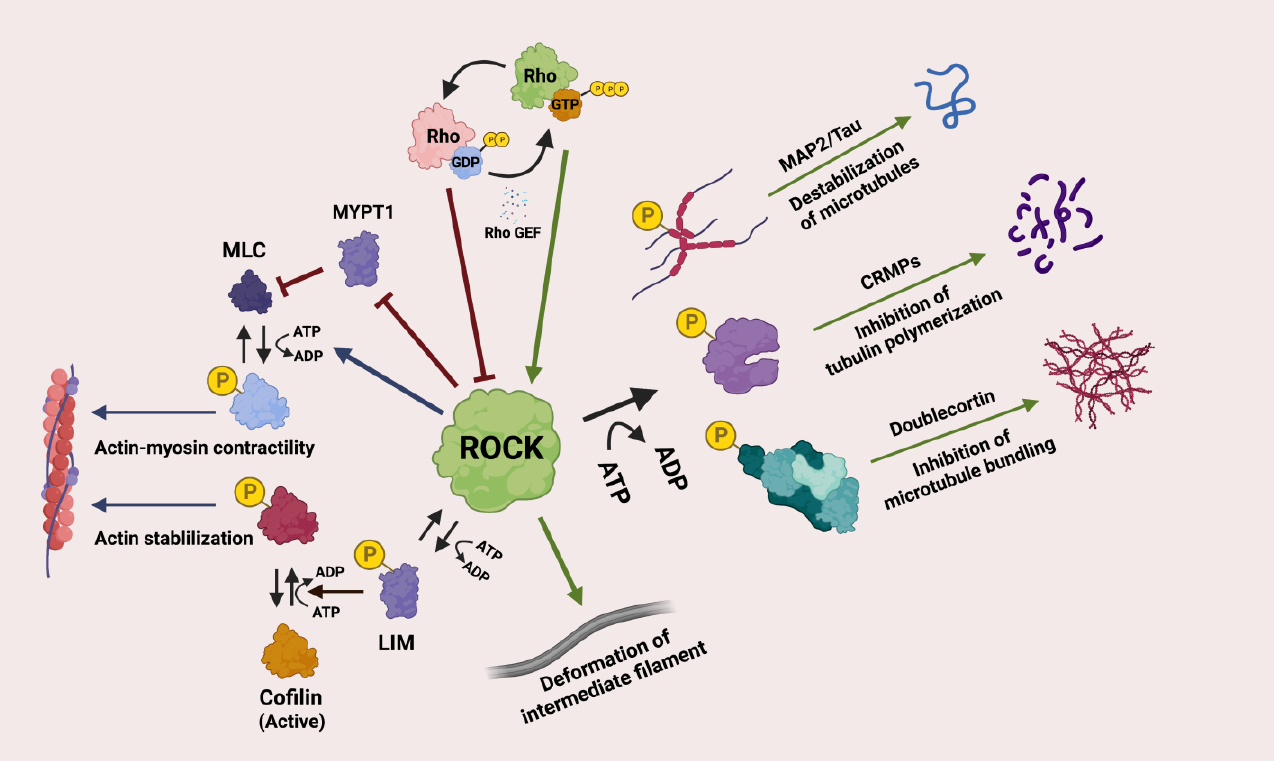
Figure 2. The functions of ROCK. Rho is activated by Rho guanine nucleotide exchange factor (GEF). Activated GTP-bound Rho stimulates ROCK. Activated ROCK activates or inhibits downstream targets by phosphorylation. Activated ROCK regulates microfilaments via the ROCK/MYPT1/MLC and ROCK/LIM kinases/cofilin pathways. ROCK also regulates intermediate filaments by phos- phorylation. ROCK regulates microtubules by phosphorylation of several microtubule-associated proteins such as MAP2/Tau, collapsin response mediator protein 2 (CRMP2) and Doublecortin. Cre- ated with BioRender.com.